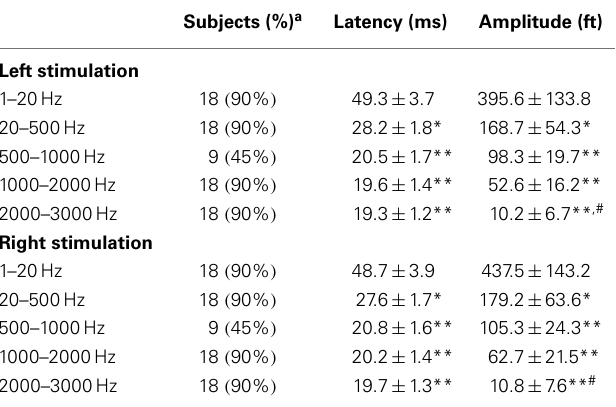
Table 1 | Latency and amplitude of somatosensory elicited magnetic fields in multi-frequency ranges (mean ± SD)